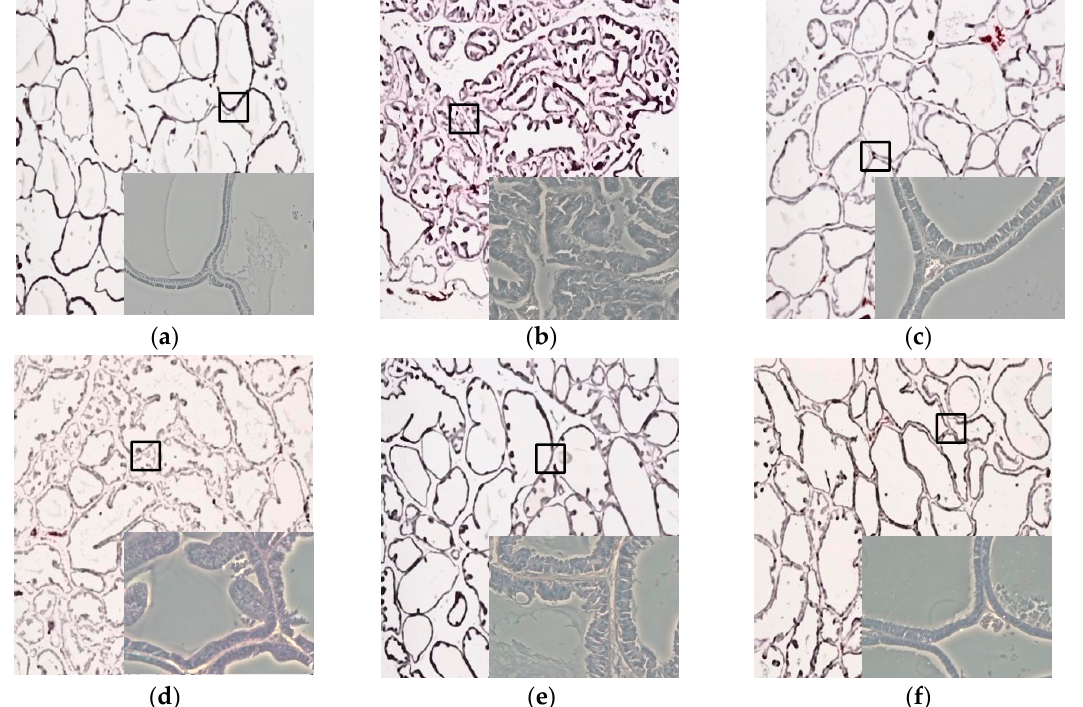
Figure 4. Effects of aqueous Cynanchum wilfordii extract (CWW) on prostate hyperplasia. Histological examination of prostate tissues was performed 24 h after the final testosterone injection. Prostate tissues were fixed, sectioned at 4- μ m thickness, and stained with hematoxylin and eosin (H&E; magnification, ×10; small box, ×20). BPH: benign prostatic hyperplasia; ( a ) Sham/vehicle: sham-operated and phosphate-buffered saline (PBS), oral (p.o.); ( b ) BPH/vehicle: testosterone, subcutaneous (s.c.) and PBS, p.o.; ( c ) BPH/finasteride: testosterone: s.c. and finasteride 5 mg/kg, p.o.;